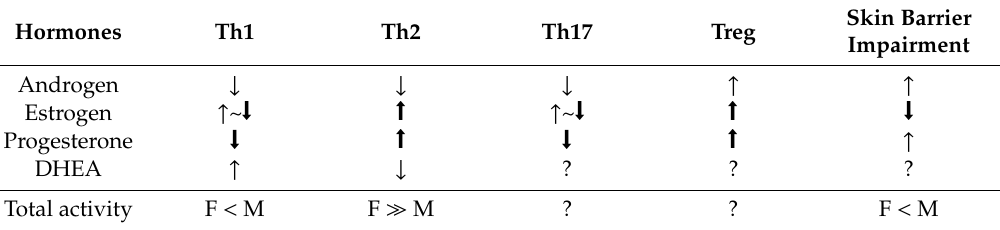
Figure 2. Menstrual cycle. Reprinted from